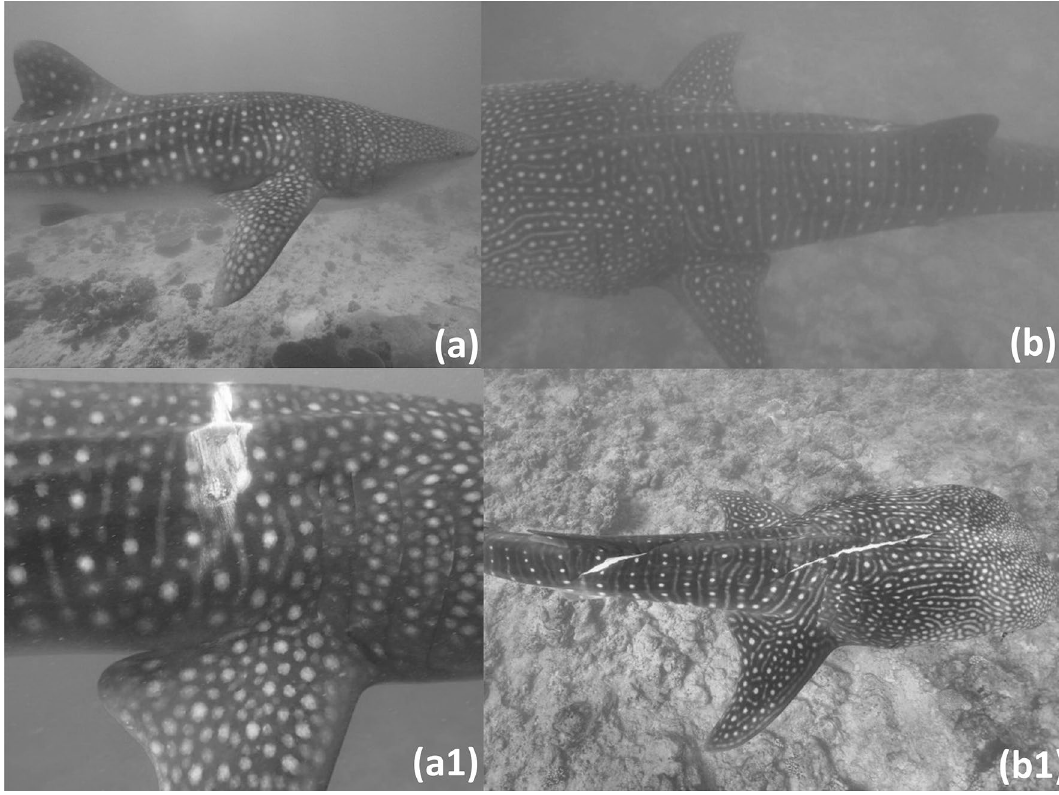
Figure 4. Example images of new major injuries obtained within estimated residency periods ( a , a1 ) and outside of estimated residency periods ( b , b1 ). This shark (WS180) was documented on 26.03.14 with no major injuries ( a ). A major impalement injury was present when the shark was next observed 6 days later on the 01.04.14 ( a1 ). ( b ) This shark (WS077) was documented on 14.01.12 with no major injuries. ( b1 ) The next sighting of WS077 (Photo credit: Big Fish Network) occurred 122 days later on the 15.05.12, and major lacerations were present. Images taken by Sighting probability (p) for sharks with no major injuries was calculated to be 1.00 (SE = 7.89 × 10 –6 ) and 0.88 for sharks with major injuries (SE = 1.88 × 10 –2 ). Nonetheless, high estimates for p indicate that the data set provides a representative picture of the aggregation within SAMPA. Abundance across years (2014–2019) was modelled as a derived result from the POPAN model (Fig. 6). Additionally gross N* population was modelled as a derived POPAN result. The gross population was estimated as 60.25 (SE = 0.74) males with major injuries and 50.19 (SE = 4.99) males with no major injuries. 3 (SE = 0) females with major injuries were estimated and 1 (SE = 0) female with no major injuries, totalling 114 individuals. Both Net and Gross births (Fig. 7) into SAMPA were calculated as derived POPAN results. Net births into the population (between times i and i + 1) was calculated to be 2.86 × 10 –11 (SE = 3.37 × 10 –9 ) for females with major injuries and 5.75 (SE = 6.32 × 10–1) for males with major injuries. For individual with no major injuries, Net births was calculated to be 9.53 × 10 –12 (SE = 6.31 × 10 –1 ) for females and 3.23 (SE = 3.55 × 10 –1 ) for males. Models predicting probability of entry (PENT) based on sex were found to be the best fit to sightings data. Male sharks had a considerably higher PENT value (0.10, SE = 0.01) than females (3.54 × 10 –17 , SE = 2.82 × 10 –15 ). Lagged identification rate. Model H (Supplementary Table 2) was the best-fit model for whale sharks with and without major injuries, which included parameters for emigration, reimmigration and mortality or permanent emigration. For whale sharks with major injuries, the LIR dropped steadily as the time lag increased (Fig. 5b), never quite reaching zero, suggesting some individuals may stay within the site over long periods of time. Contrastingly, the LIR for whale sharks without major injuries was very high (0.125) after 1 day, then dropped off quickly as the time lag increased, reaching zero after ~ 4400 days or ~ 12 years (Fig. 5b). Parameter estimates showed that sharks with major injuries had a mean initial residency of 46.5 (SE = 10.8) while non- injured sharks had a mean initial residency of 69.9 (SE = 29.8) days. Sharks with major injuries spent a mean of 28.5 (SE = 7.7) days outside the study area, whilst non-injured sharks spent 18.1 (SE = 14.8) days outside the study area before re-entering the study site. Mean mortality was estimated at 0.0004 (SE = 0.0002) for sharks with major injuries and 0.001 (SE = 0.001) for non-injured sharks, indicating an apparent survival of 0.85 and 0.49 year −1 respectively. The model also estimated daily abundance at the site, with 13.7 (SE = 1.7) sharks with major injuries and 9.0 (SE = 1.9) non-injured sharks present.